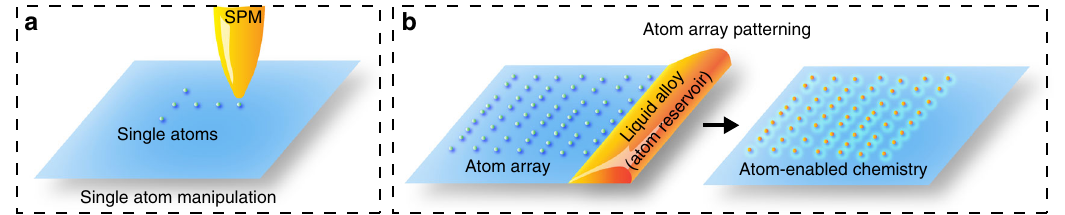
Fig. 1 Liquid alloy may be used for atom manipulation. a Schematic illustrations of single atom manipulation by SPM and b large-scale and sequential manipulation of atom arrays with liquid alloy